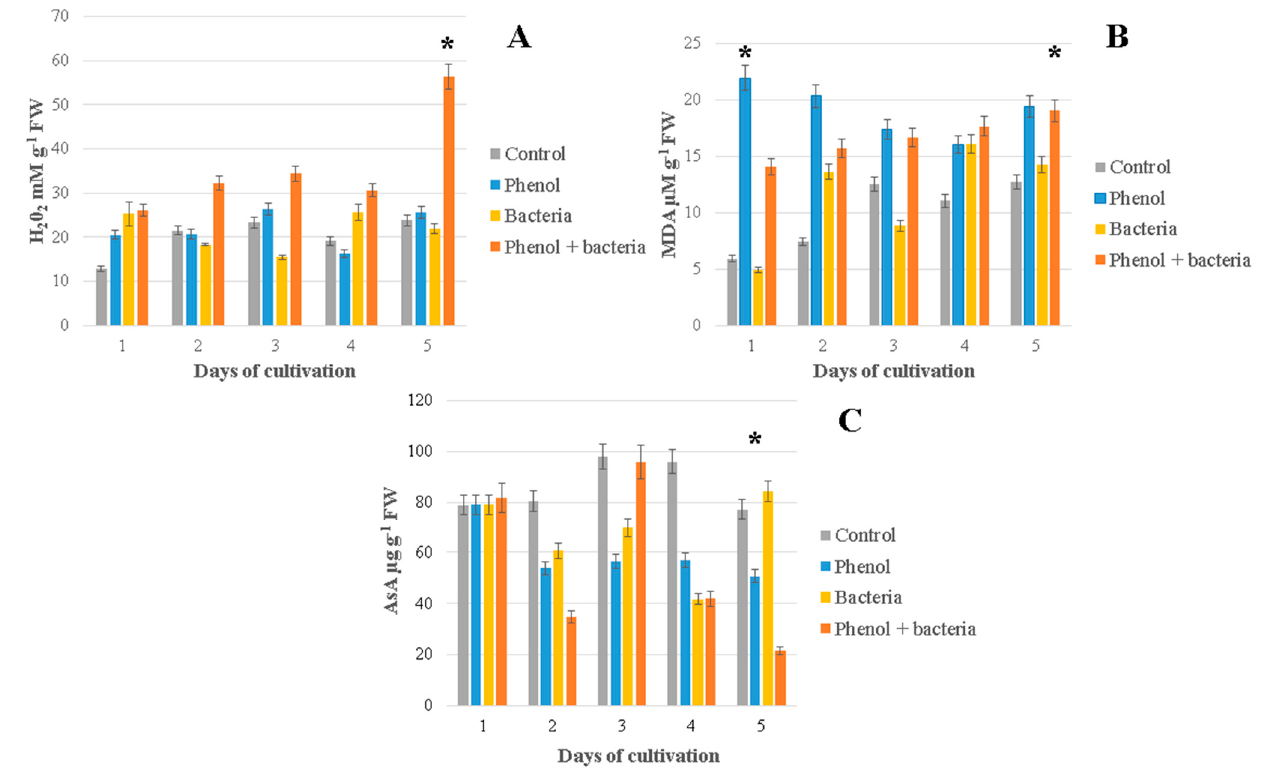
Figure 4. Non-enzymatic antioxidative parameters of duckweeds cultivated under different experimental conditions: ( A ) hydrogen peroxide (H 2 O 2 ); ( B ) malondialdehyde (MDA); ( C ) ascorbic acid (AsA). Control—sterile duckweeds cultivated in phenol-free MS medium; Phenol—sterile duckweeds cultivated in phenol-supplemented MS medium; Bacteria—duckweeds inoculated with bacteria H. paralvei and cultivated in phenol-free MS medium; Phenol + bacteria—duckweeds inoculated with bacteria H. paralvei and cultivated in phenol-supplemented MS medium. Concentration of phenol in all experiments was 500 mg L − 1 . Data represent the mean ± SE ( n = 3). * indicates significant differences between treatments at p < 0.05.